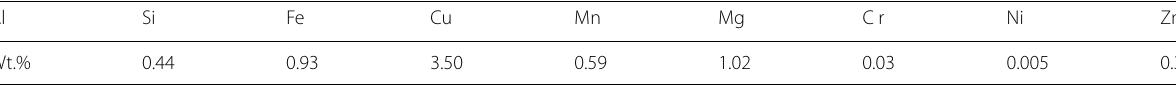
Table 1 Chemical composition of AA6063